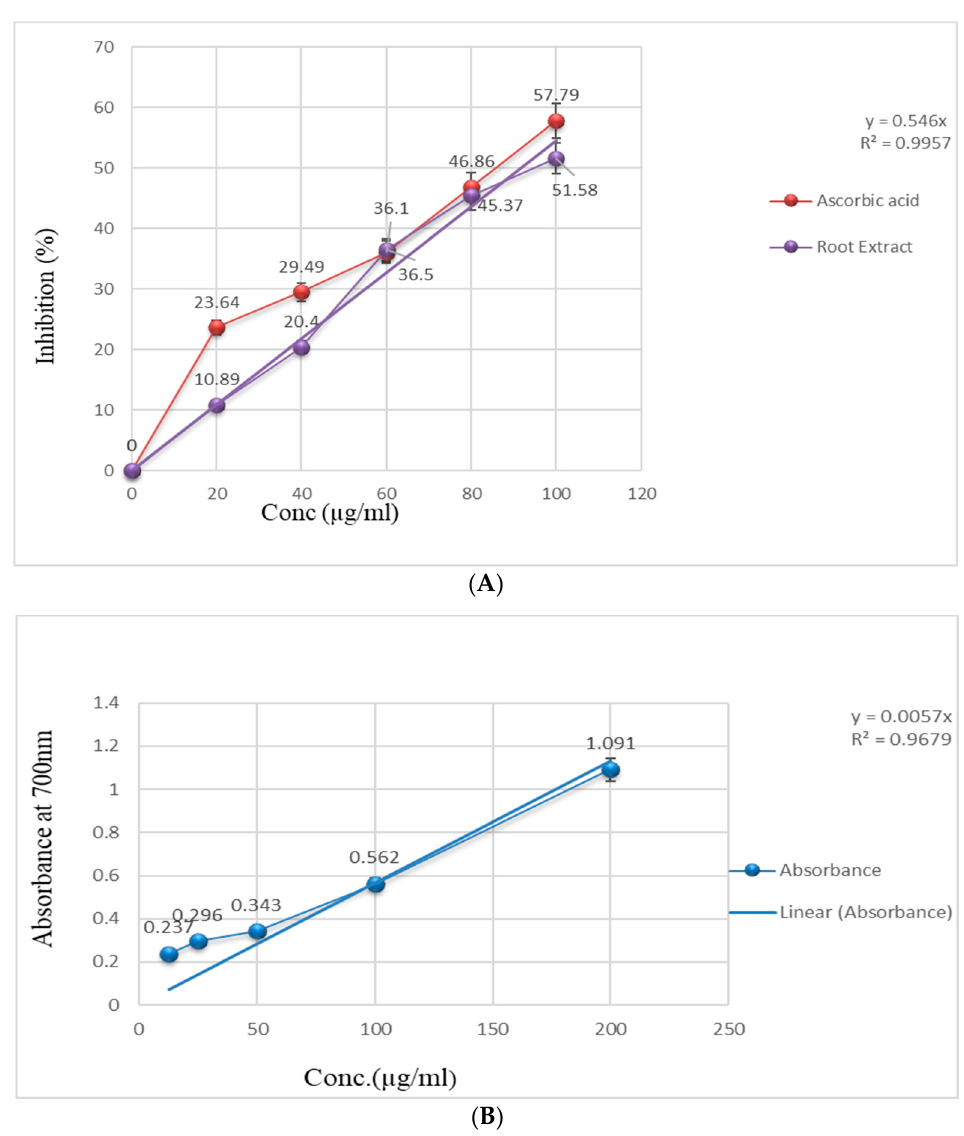
Figure 4. ( A ) Free radical scavenging activity of the n-butanol extracts from roots of S. lappa and positive controls measured in DPPH assay. ( B ) Absorbance of FRAC assay of root extract at different concentrations.